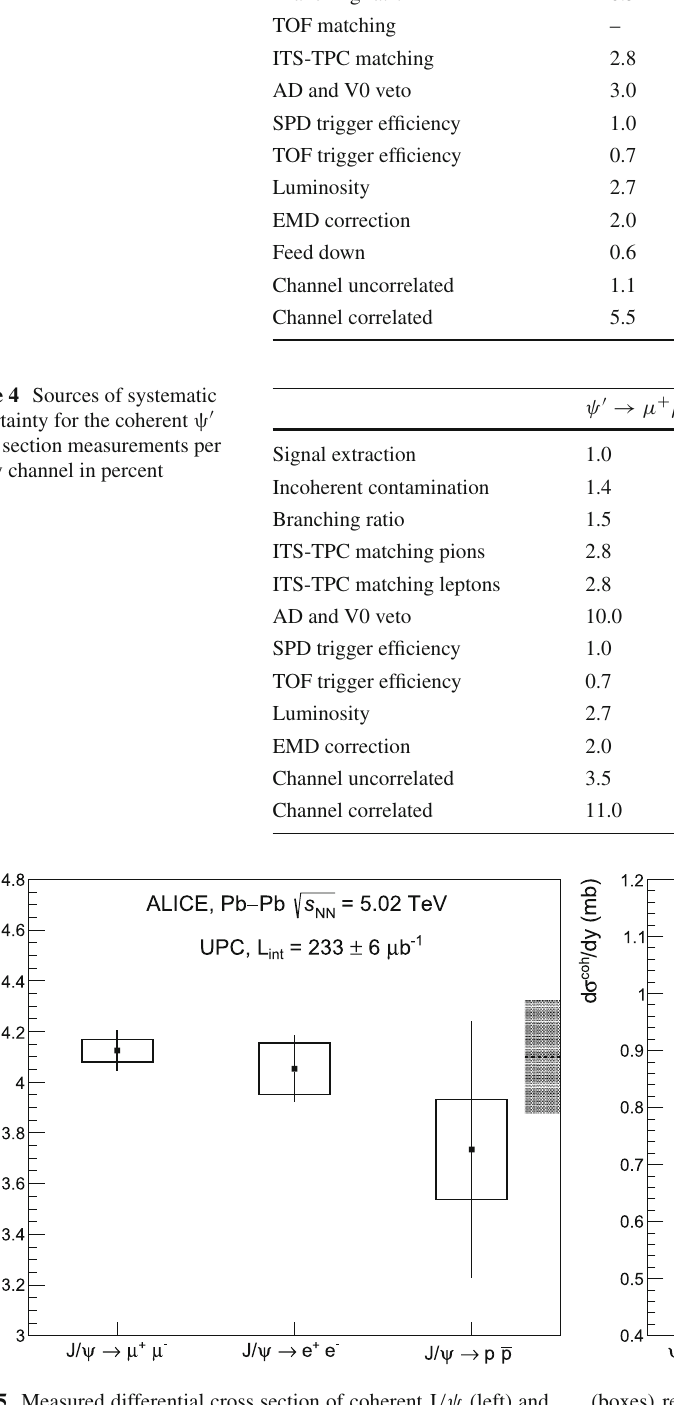
Fig. 5 Measured differential cross section of coherent J /ψ (left) and ψ (cid:2) (right) photoproduction in Pb–Pb UPCs in | y | < 0 . 8. The points show the measurements for different decay channels. The error bars